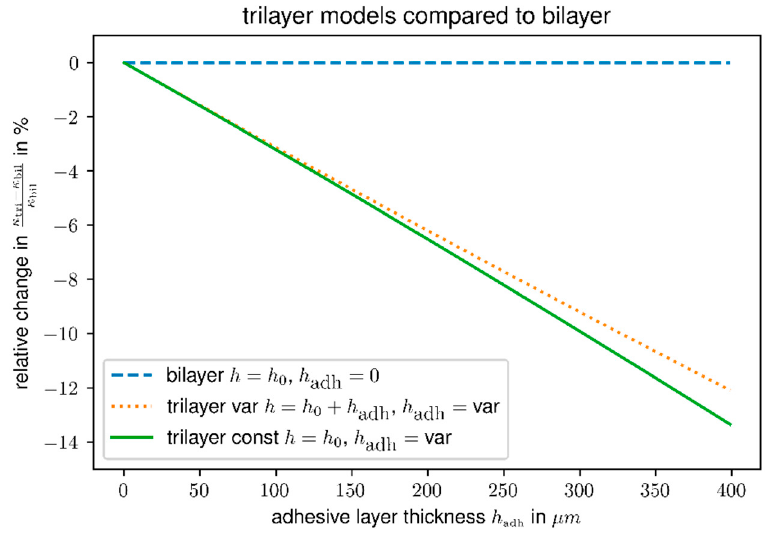
Figure 4. Relative change of curvatures of tri-layer model compared to bilayer model as a function of thickness of adhesive layer: dashed line, bilayer-reference; dotted line, adhesive forms a distinguishable glueline; solid line, adhesive penetrates wood and forms an interlayer.